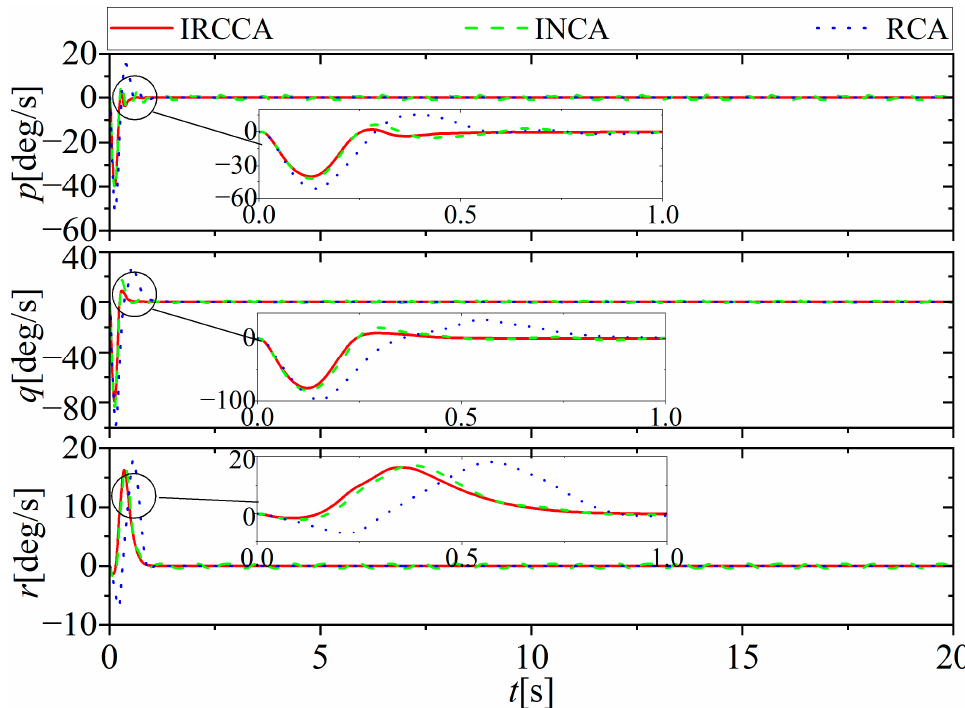
Figure 14. Time response of the attitude angle rate with a loss of effectiveness fault.